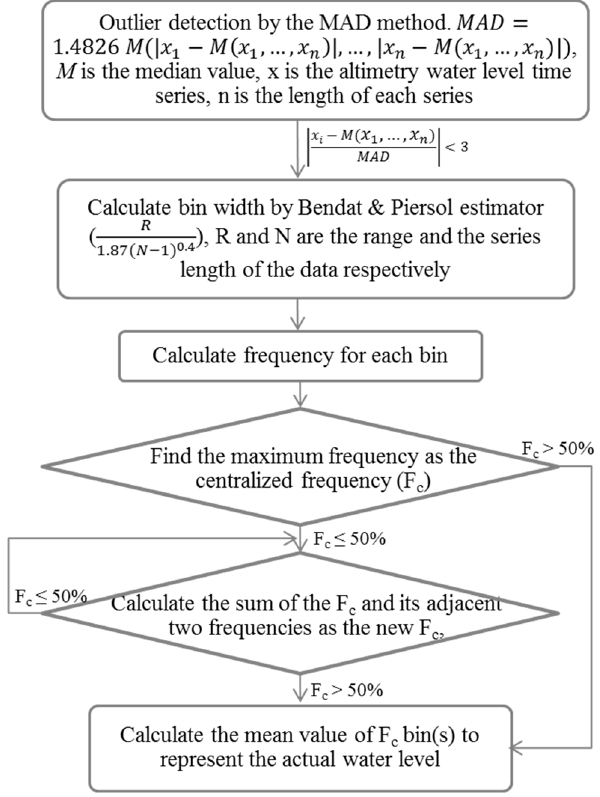
Figure 2. The procedure of the concentrated probability density function (PDF) method.